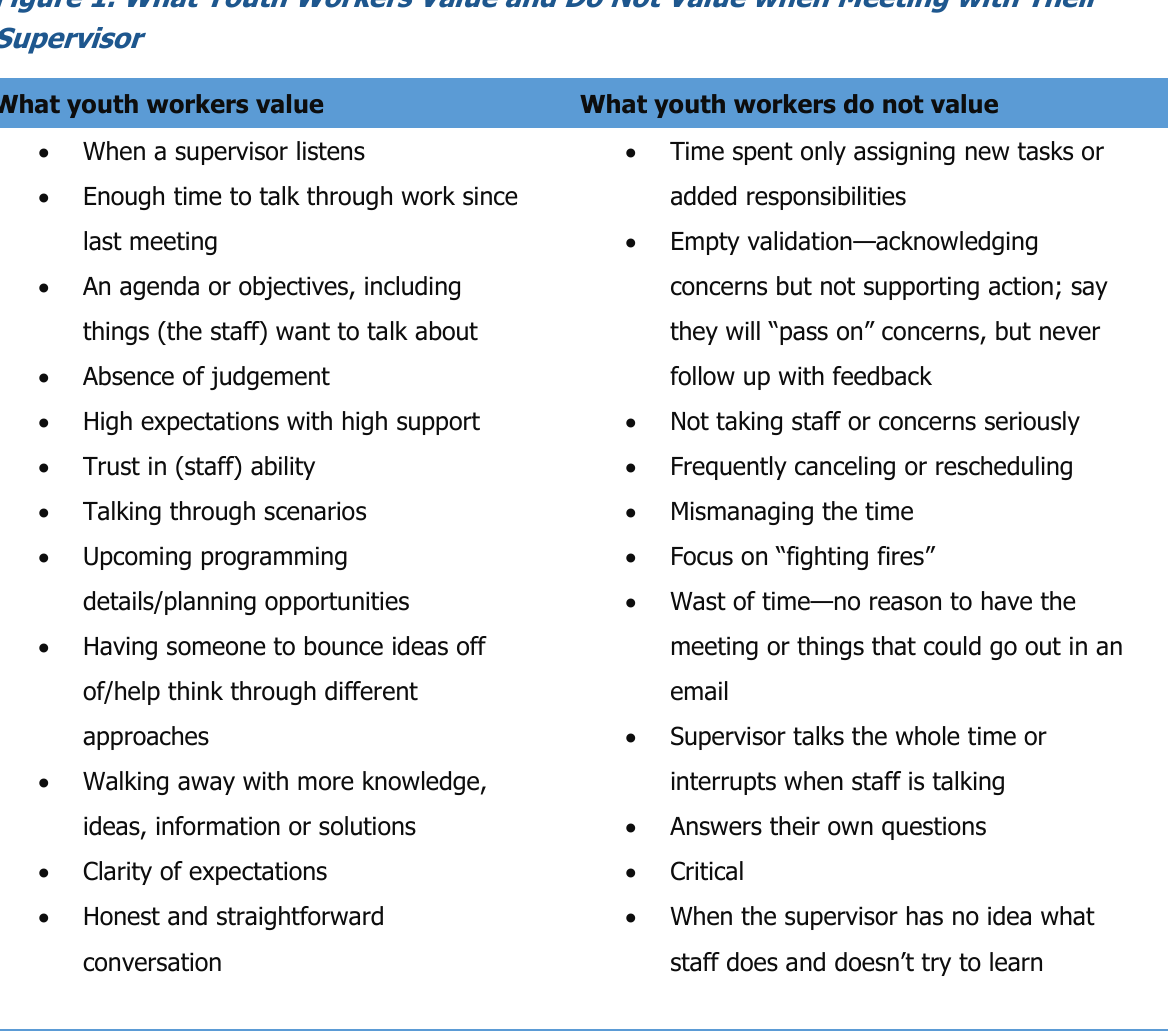
Figure 1. What Youth Workers Value and Do Not Value when Meeting with